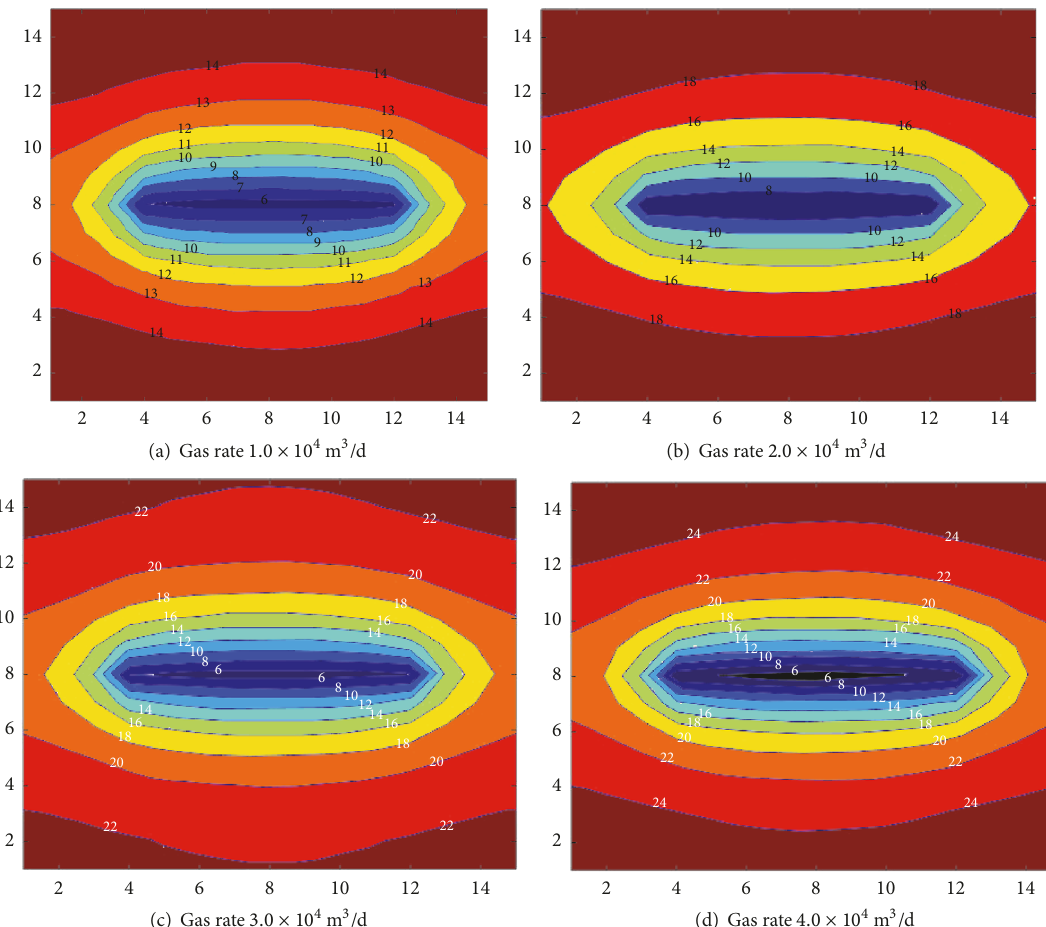
Figure 20: The pressure distribution after stabilized production stage under different gas